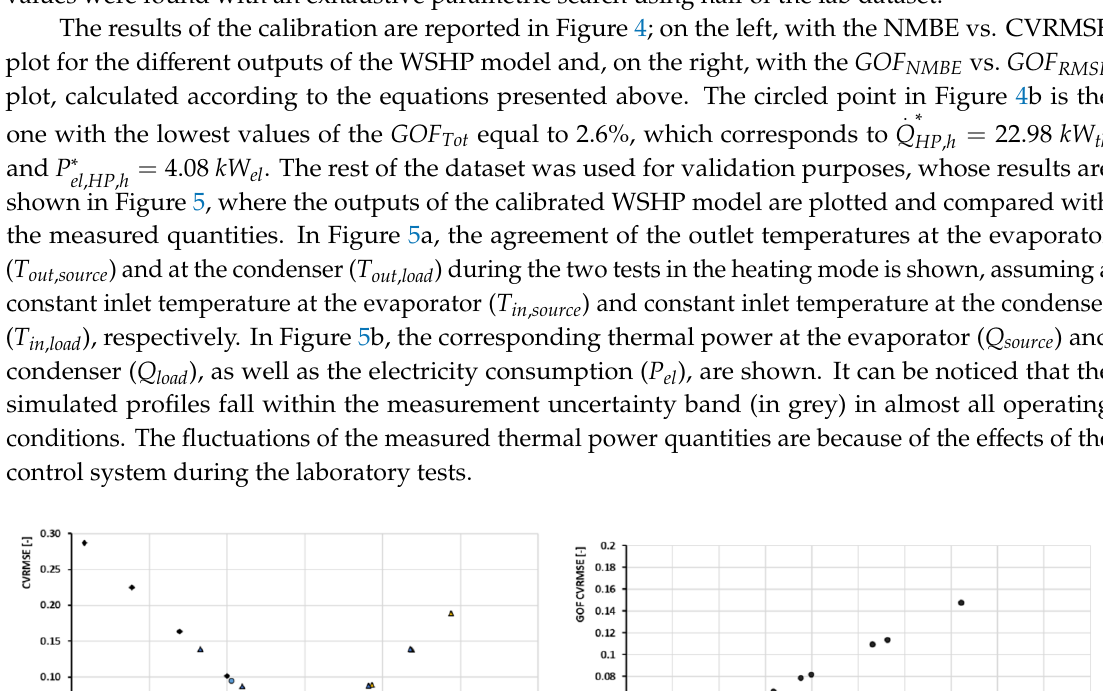
Figure 5. Results of the WSHP model validation: ( a ) measured vs. simulated inlet and outlet temperatures and ( b ) electrical and thermal powers.